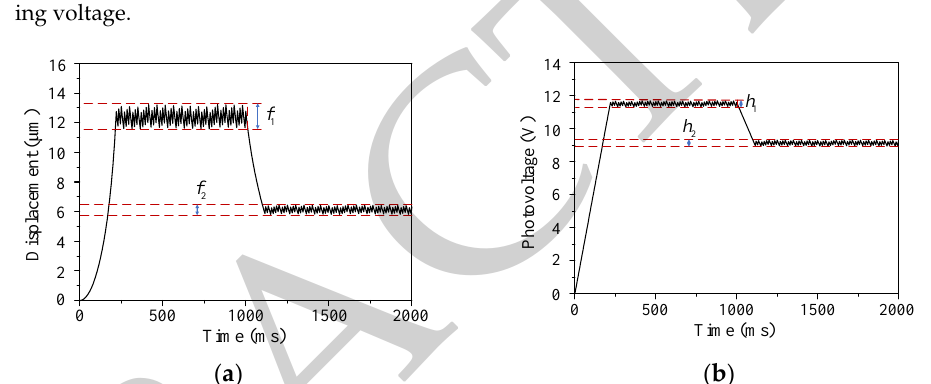
Figure 7. The closed-loop control simulation curve of photovoltaic-electrostatic hybrid actuator illuminated by light intensity of 20 mW/cm 2 . ( a ) Time history of displacement. ( b ) Time history of photovoltage.